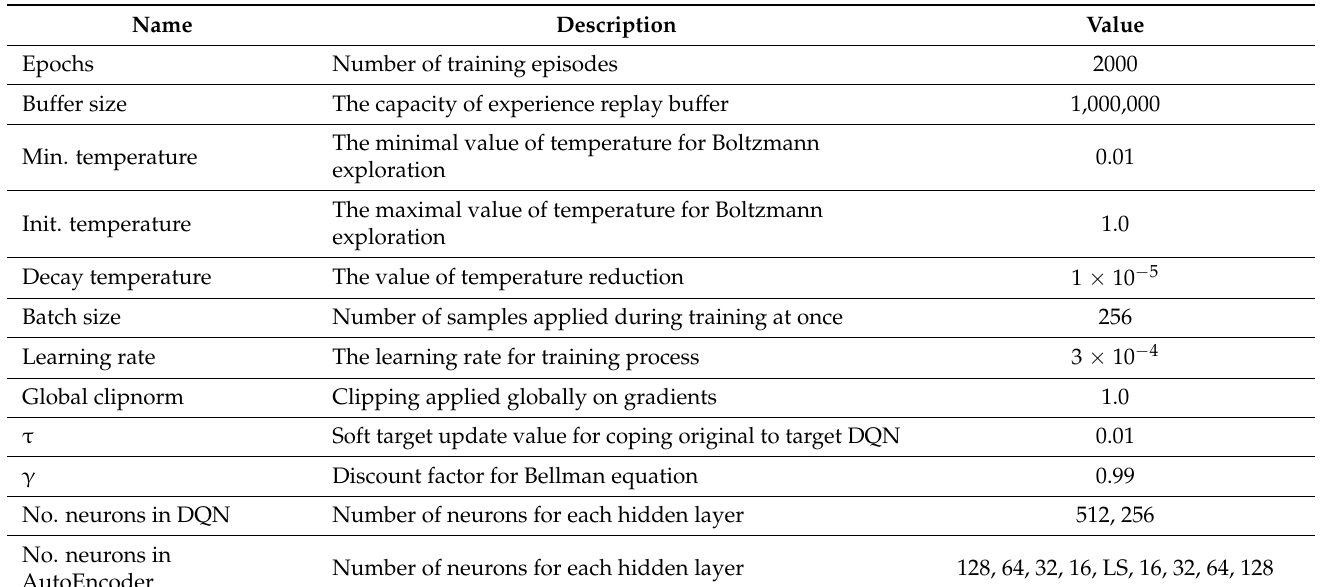
Table 2. Optimized hyperparameters for Dueling DQN